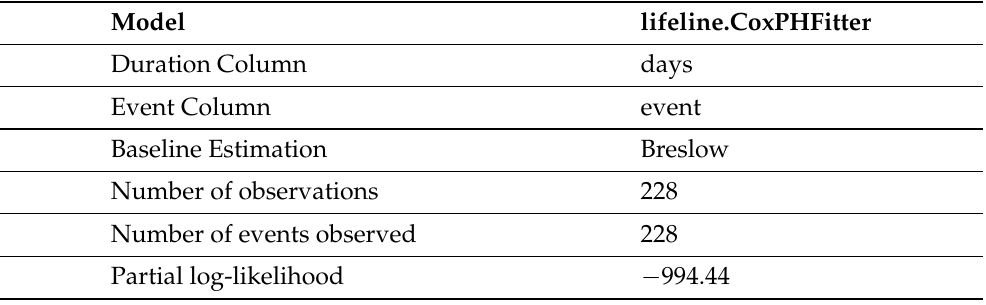
Table 4. Summary of the parameters used for training the CoxPHFitter